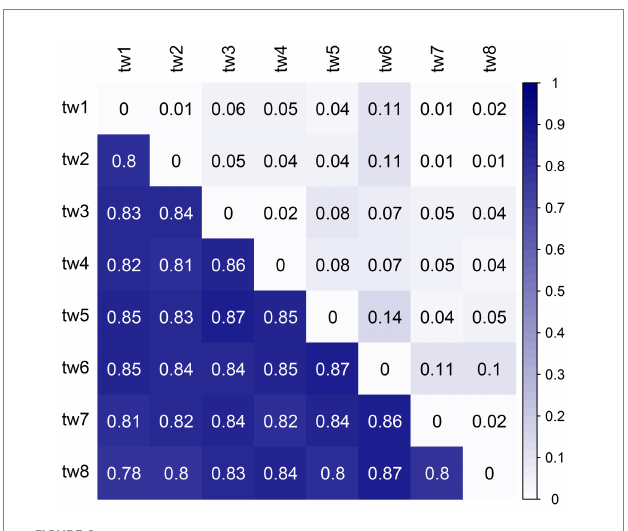
FIGURE 6 Heat map of Unifrac distances between samples. The upper triangle is the weighted Unifrac distance, and the lower triangle is the unweighted Unifrac distance. Unifrac distance combines community composition and phylogenetic distance. The weighted Unifrac distance also considers species richness, while the unweighted Unifrac distance only considers the presence or absence of species. Therefore, the unweighted Unifrac distance emphasizes rare species, and the weighted Unifrac distance has a low contribution of rare